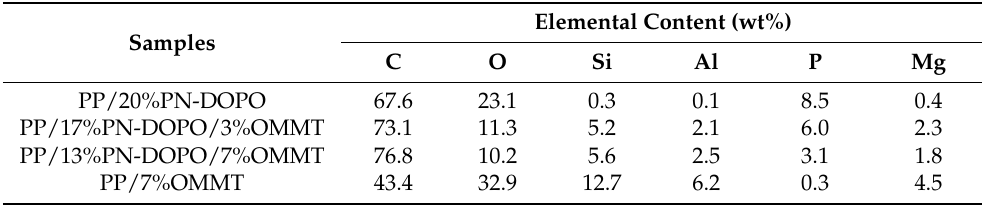
Table 4. Element contents of the char residues of flame-retarded PP